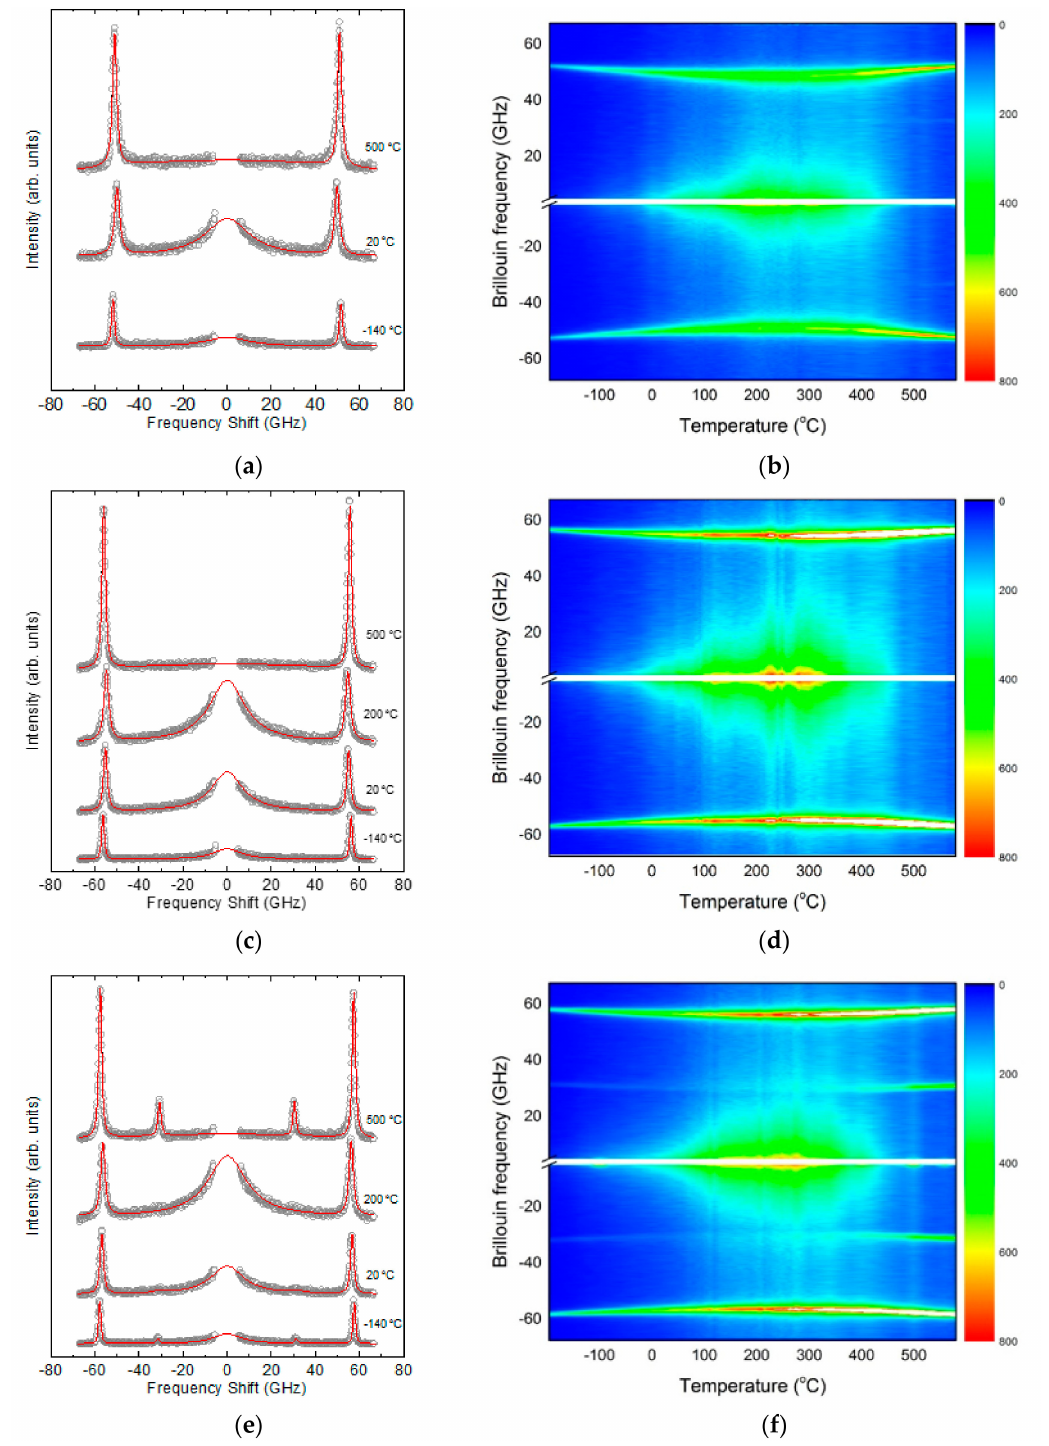
Figure 1. Temperature dependence of the Brillouin scattering spectra of NBT-5%BT for the phonon propagation direction along the ( a ) <100>, ( c ) <110>, and ( e ) <111> directions. The solid lines denote the best-fitted results as described in the text. The right figures ( b ), ( d ), ( f ) show the intensity color plots for the Brillouin spectra of each corresponding